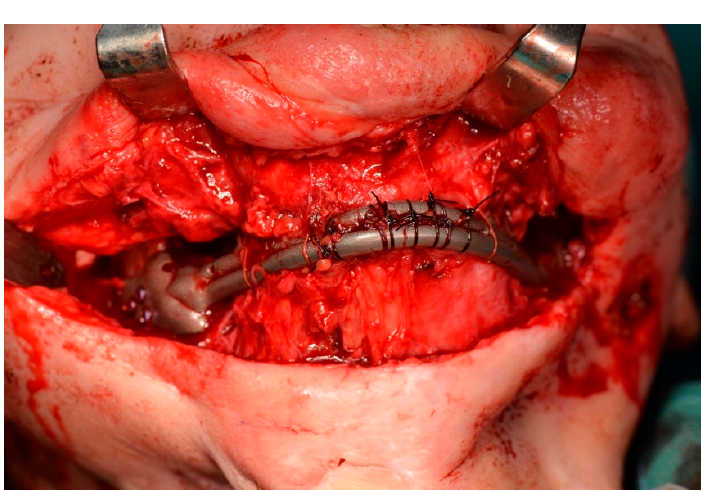
Figure 11. Lateral view.